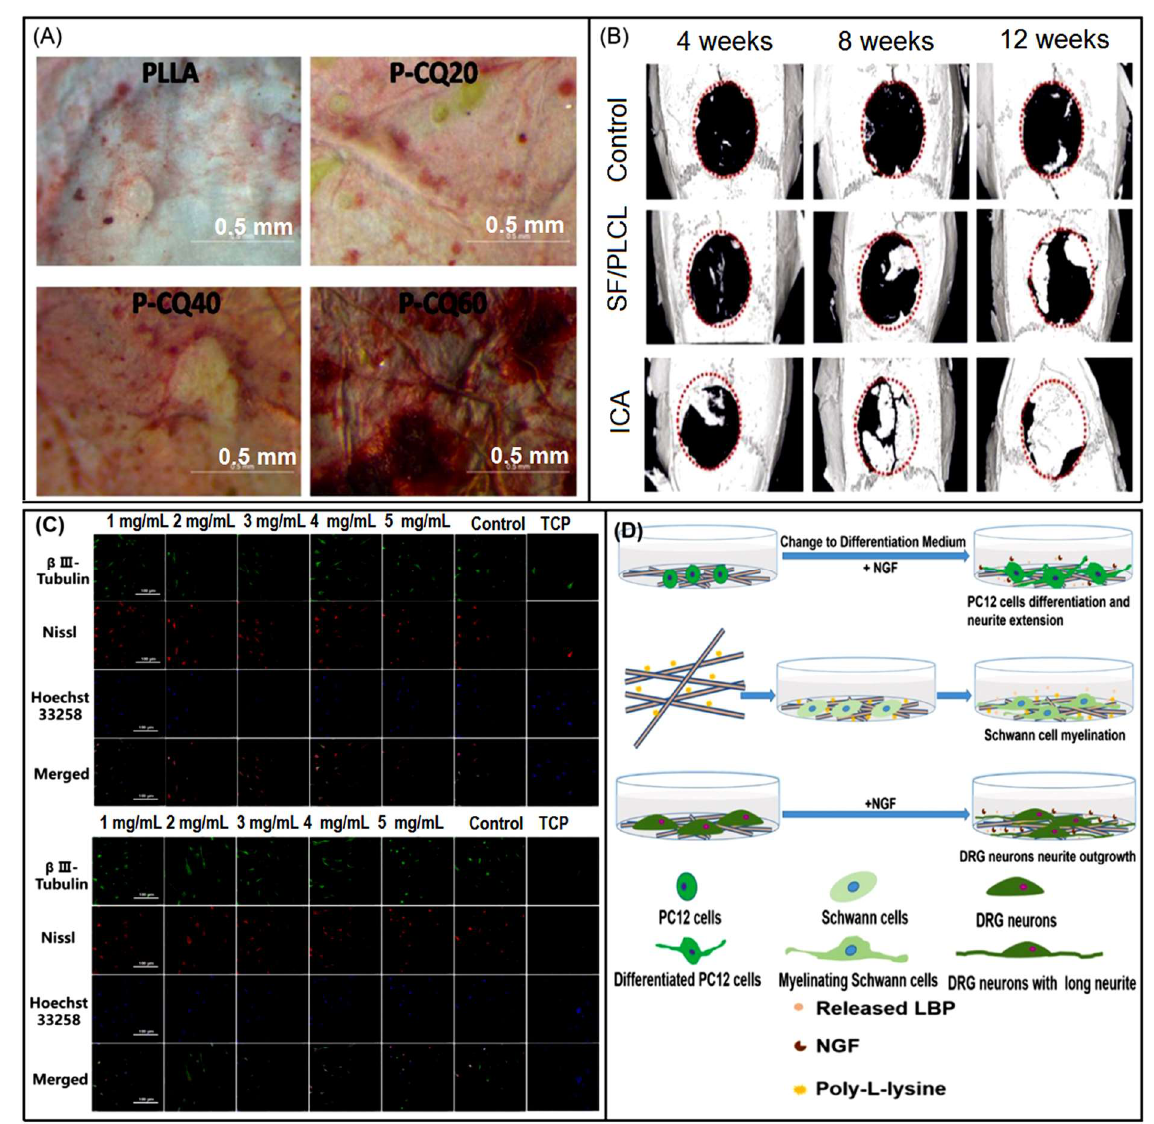
Figure 13. Application of pharmacological activity of herbal medicine in tissue engineering. ( A ) Mineralization micrograph, reprinted with permission from [184] copyright 2017, Elsevier. ( B ) Potential of ICA-SF/PLCL scaffold for bone regeneration, reprinted with permission from [234] copyright 2017, Scientific Reports. ( C ) The effect of (PLGA/MWCNTs/SF)-Catapol scaffold on neuronal differentiation of hASCs; ( a ) Three days; ( b ) 5 days [15], reprinted with permission from [15] copyright 2015, Biomedical Engineering Society. ( D ) Effect of PLGA-LBP scaffold on proliferation and differentiation of PC12 cells and myelination of Schwann cells to promote nerve growth, reprinted with permission from [50] copyright 2018, Scientific Reports.